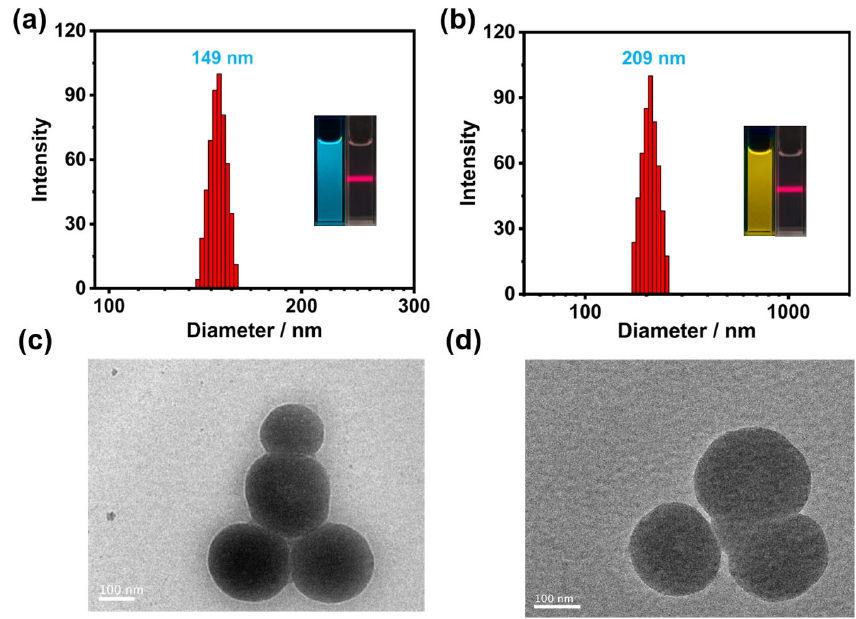
Figure 2. DLS data of ( a ) M NPs, inset: Photographs M NPs (left) under 365 nm UV lamp and the Tyndall effect of M NPs (right) and ( b ) M ‐ DBT NPs, Photographs M ‐ DBT NPs (left) under 365 nm UV lamp and the Tyndall effect of M ‐ DBT NPs (right). TEM images of ( c ) M NPs and (d) M ‐ DBT NPs. [ M ] = 5 × 10 − 5 M, [ DBT ] = 5 × 10 − 7 M, respectively.